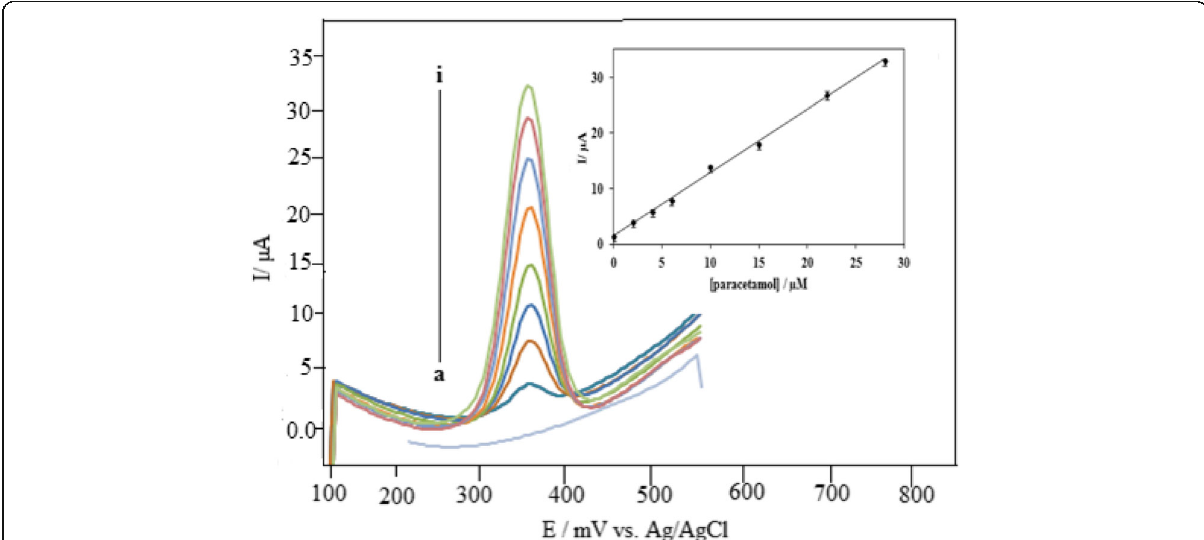
Fig. 10 SWVs on B 2 O 3 /MWCNT/GCE for different paracetamol concentrations (a – i): 0.0, 0.05, 2.0, 4.0, 6.0, 10.0, 15.0, 22.0, and 28 μ M in 0.1 M PBS (pH 4.0). Inset is the relationship of current responses to paracetamol concentration. Error bar = ± S.D. and = 3